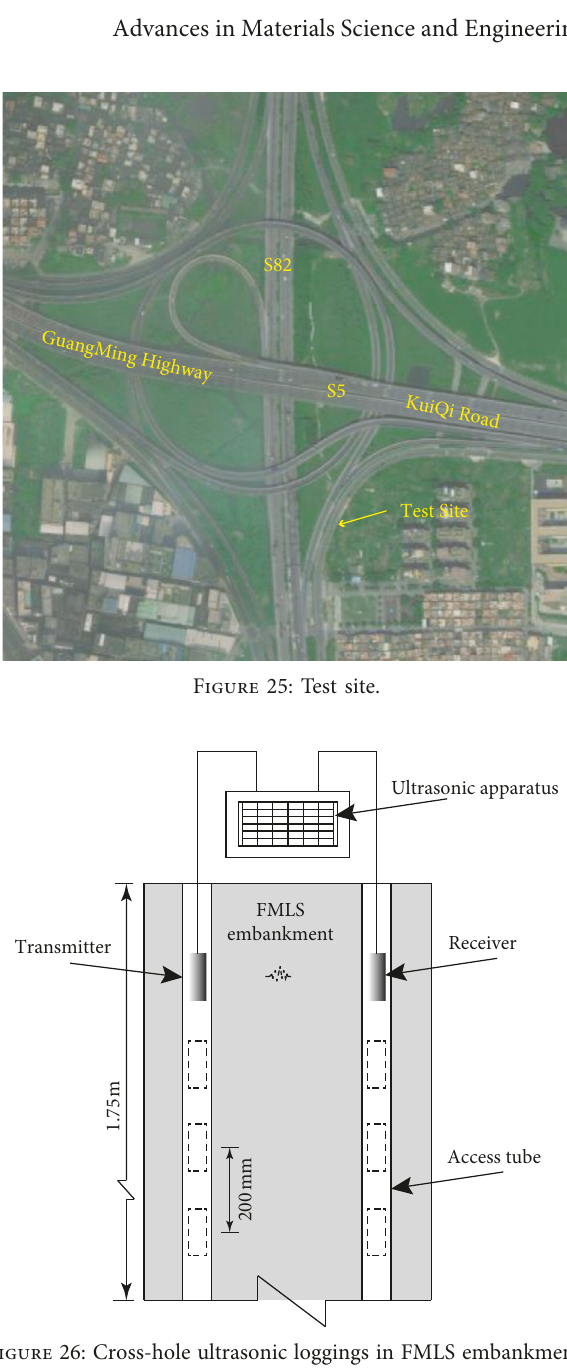
Figure 26: Cross-hole ultrasonic loggings in FMLS